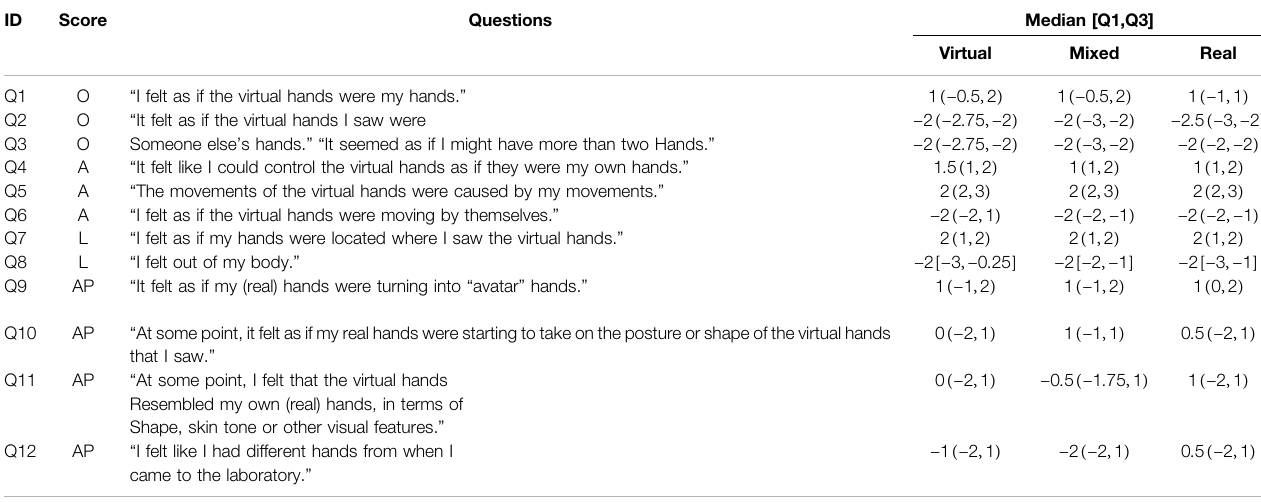
TABLE 1 | The embodiment questionnaire, adapted from Gonzalez-Franco and Peck (2018).